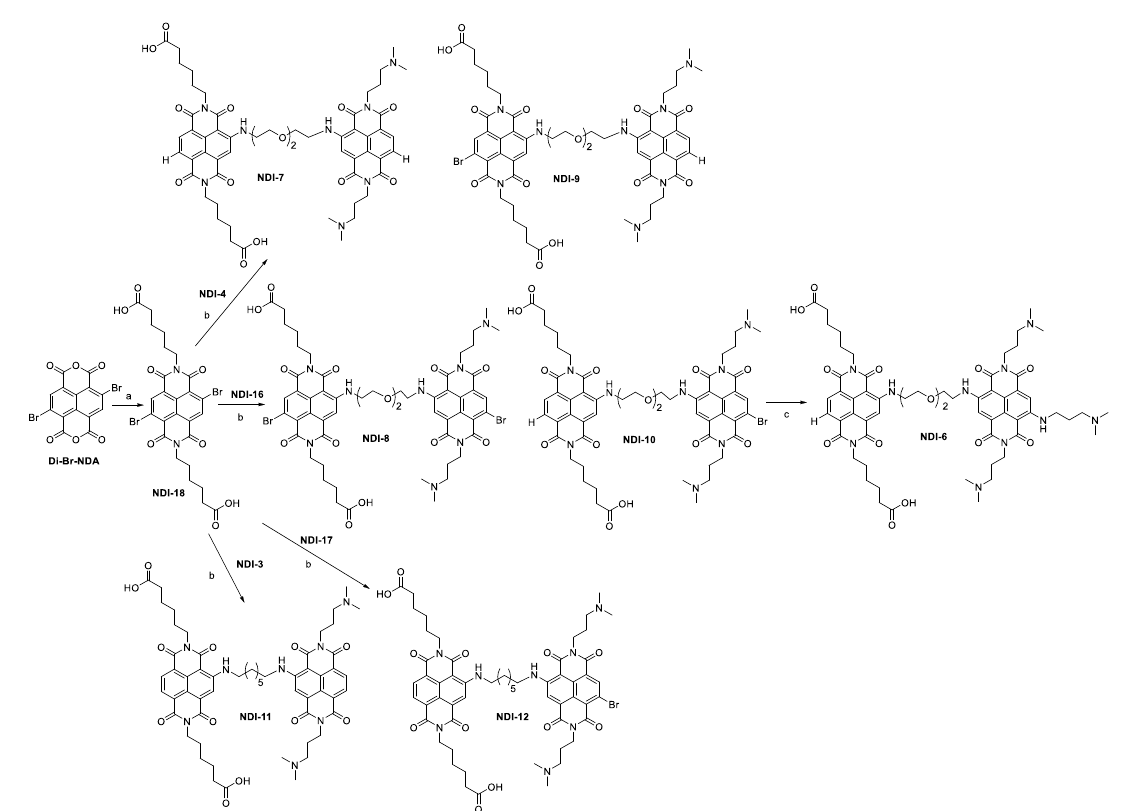
Figure 4. Synthesis of the dimeric NDIs 6 – 12 : letter a denotes 6-aminohexanoic acid (four equivalents), glacial acetic acid, 120 °C, 20 min, closed-vessel microwave-assisted; letter b denotes NDI-18 (0.95 equivalent) with one equivalent of 3 or 4 or 16 or 17 and five equivalents of DIPEA in DMF, 110 °C, 20 min, closed-vessel MW-assisted; letter c denotes NDI-10 in neat N 1 , N 1 -dimethylpropane-1,3-diamine, 180 °C, 5 min, closed-vessel microwave-assisted.